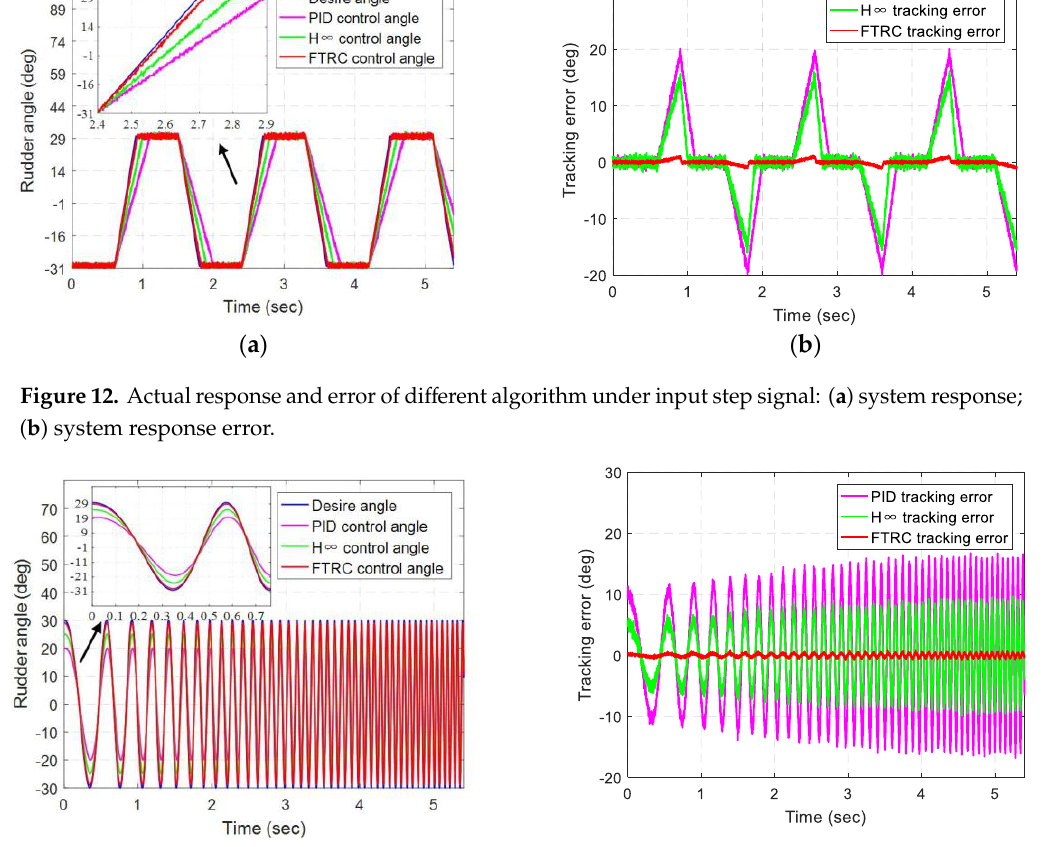
Figure 13. Actual response and error of di ff erent algorithm under input chirp signal: ( a ) system response; ( b ) system response